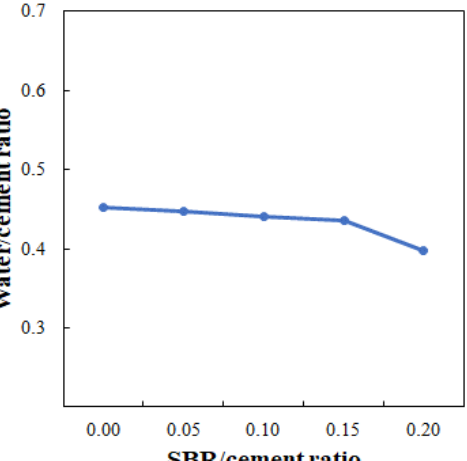
Figure 5. Elapsed time versus flow.